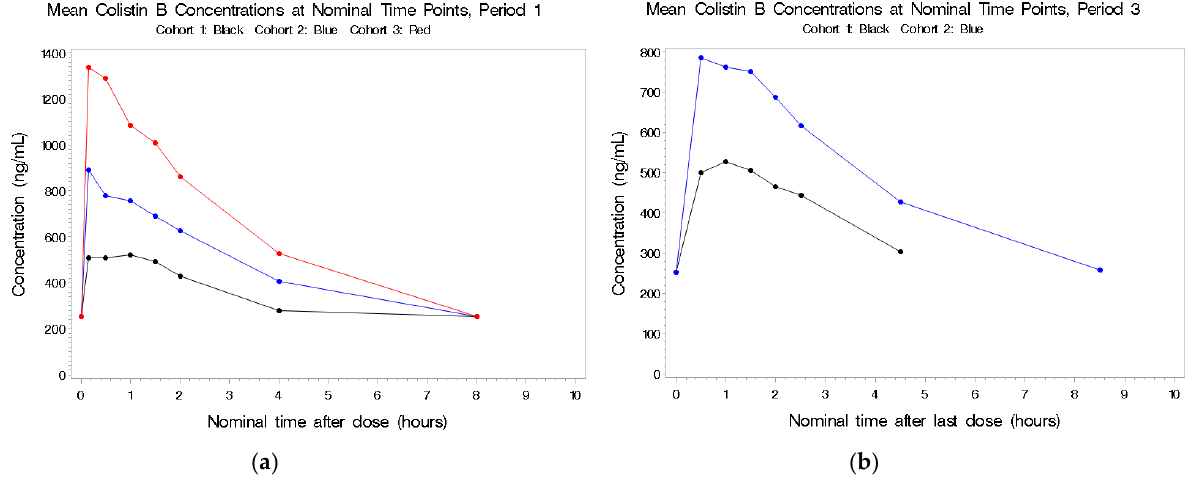
Figure 2. ( a , b ) Mean plasma concentrations for colistin B after last dose in Period 1 by cohort.